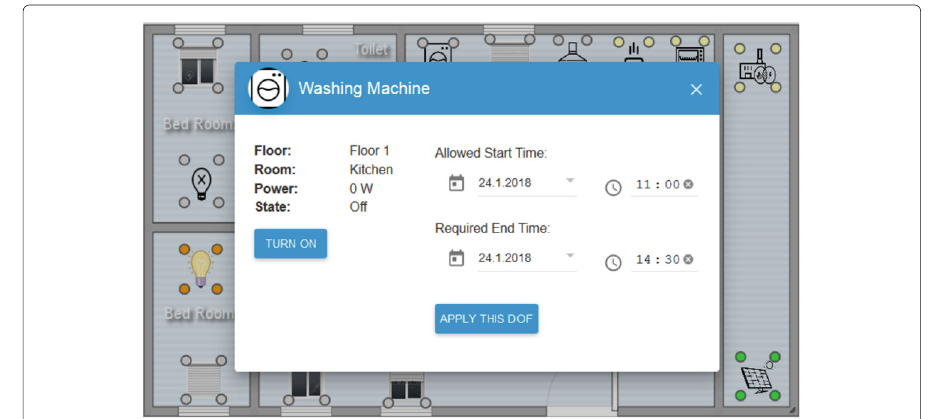
Fig. 17 BOS UI: detailed information of a washing